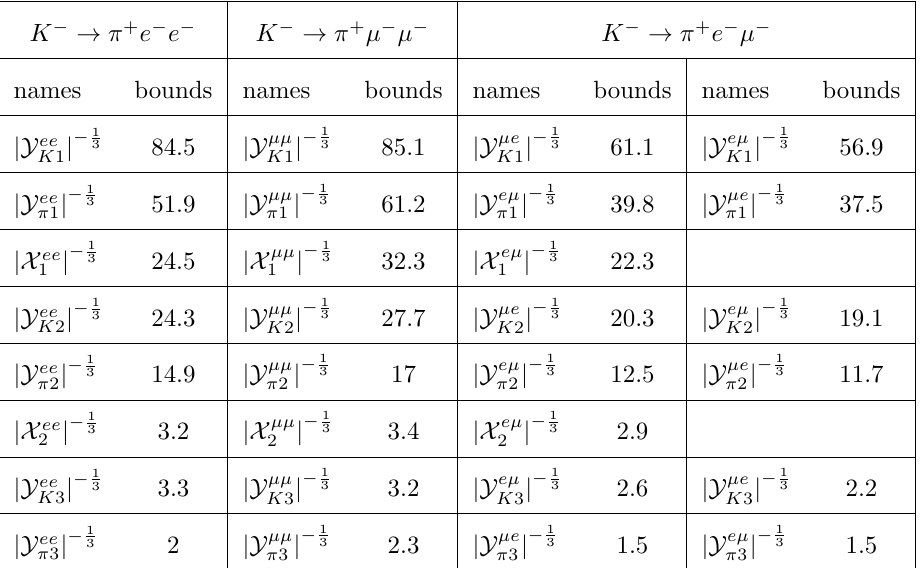
= X (cid:12)(cid:11) i i